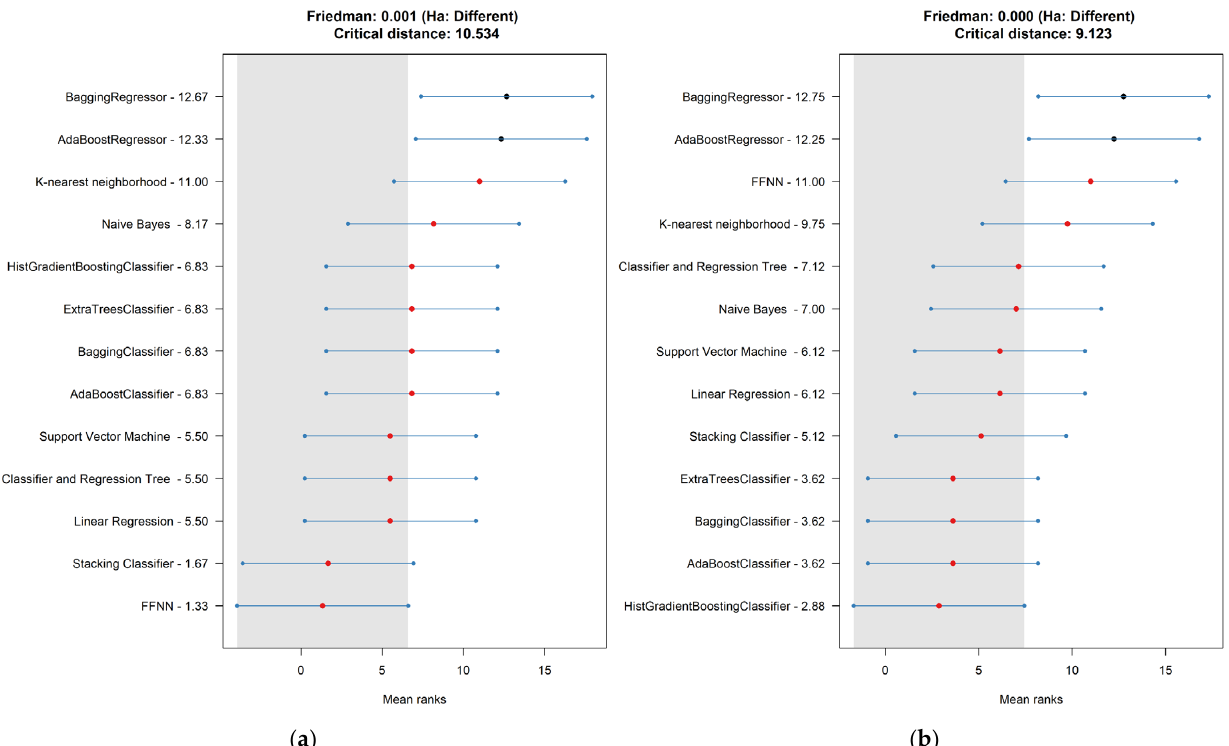
Figure 9. Critical Distance diagram from post hoc Nemenyi test: ( a ) 2-class classification scenario, and ( b ) 3-class classification scenario showing mean ranks of the methods. The mean ranks falling within a grey box marking the critical distance are not statistically different. Red dot marks the mean rank. Blue dots mark the confidence interval.